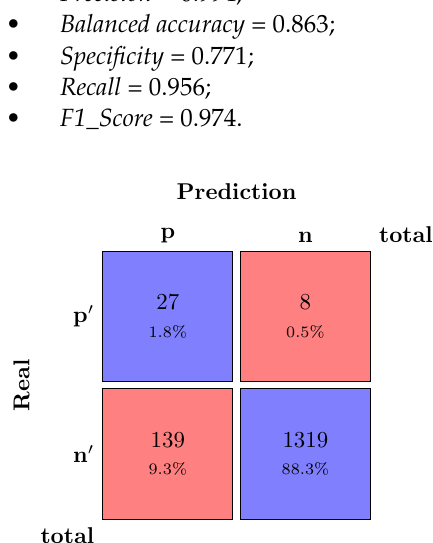
Figure 5. Confusion matrix—CI